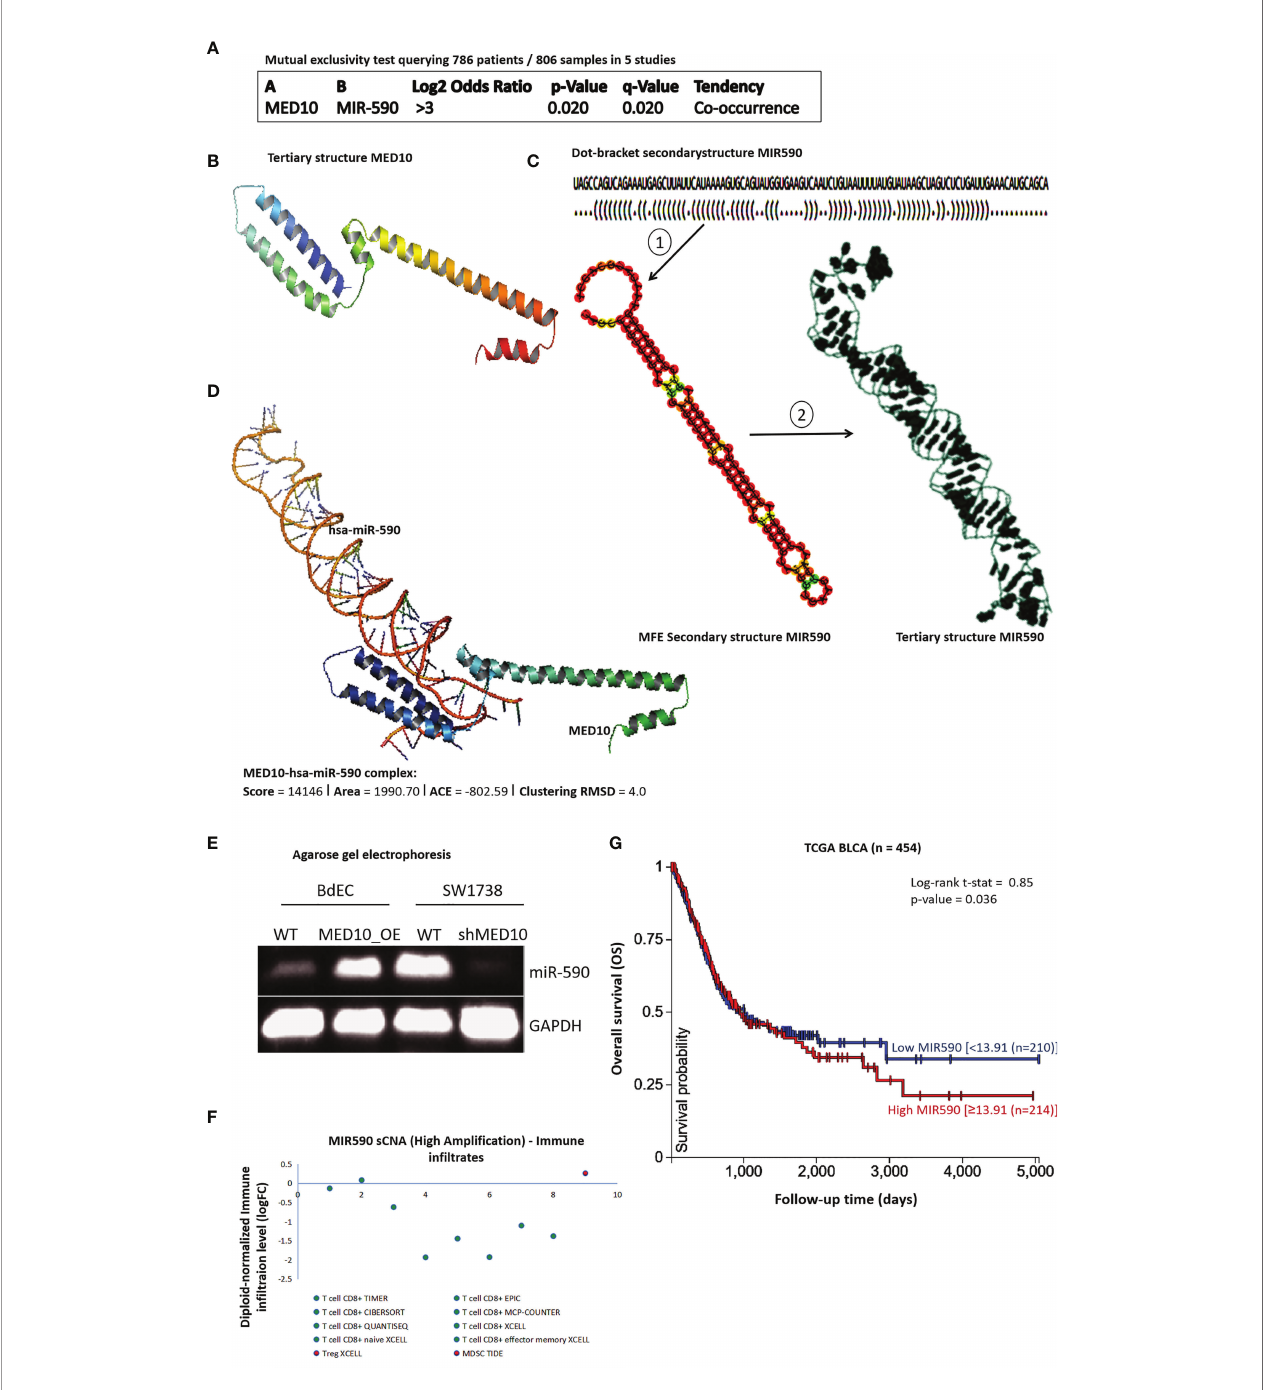
FIGURE 4 | MED10 interacts directly with hsa-miR-590, a modulator of immune in fi ltration and survival. (A) Depiction of mutual exclusivity test data showing tendency and likelihood of MED10 and hsa-miR-590 to co-occur in pool of 5 BLCA/UC studies. (B) Sequence-derived 3D structure of MED10. (C) The optimal secondary structure in dot-bracket notation with a minimum free energy (MFE) of − 31.20 kcal/mol (upper) . The RNAfold-generated MFE secondary folding structure pattern of hsa-miR-590 (lower left) . The hsa-miR-590 3D structure generated based on the secondary structure in dot-bracket notation (lower right) . (D) Molecular docking showing the direct interaction between MED10 and hsa-miR-590. The 3D transformation data, consisting of three rotational angles (2.42°, 0.38°, 120.70°) and three translational parameters ( − 1.18, − 53.27, − 102.28) applied on the ligand molecule, hsa-miR-590. (E) Representative agarose gel electrophoresis image of the effect of altered MED10 protein expression on the expression level of hsa-miR-590 in BdEC and SW1738 cells. GAPDH served as loading control. WT, wild type. (F) Dot plot showing the effect of high ampli fi cation of hsa-miR-590 on the immune cell in fi ltration levels. (G) Kaplan – Meier plot of the effect of altered hsa-miR-590 expression in the TCGA BLCA